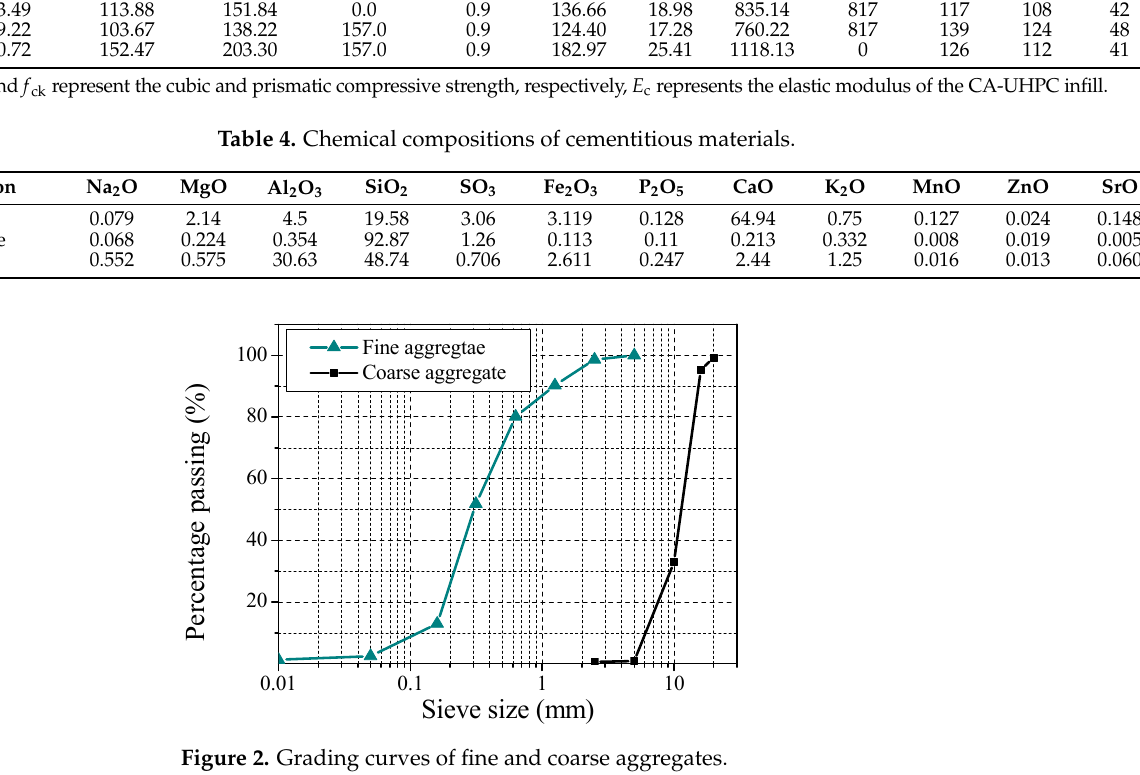
Table 3. Mix proportions and mechanical properties of CA-UHPC.